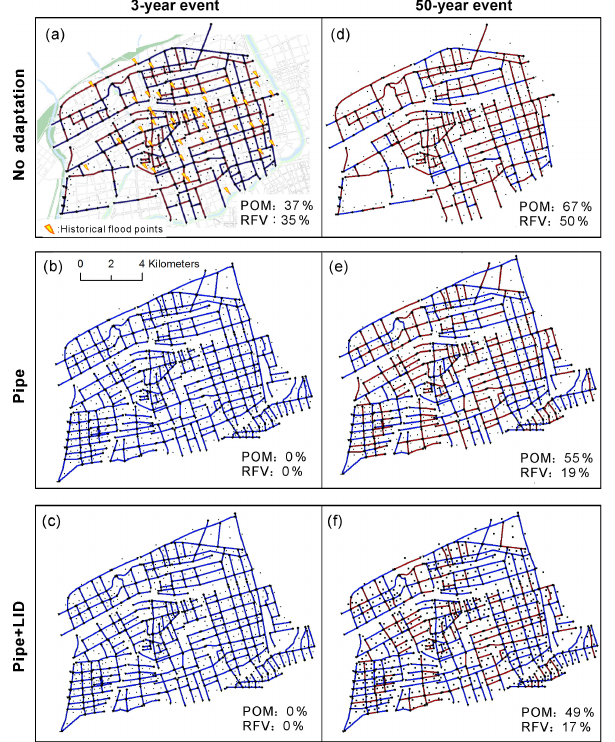
Figure 5. Spatial distribution of overloaded pipelines (red colour) induced by the 3-year (a–c) and 50-year extreme events (d–f) with- out and with adaptations. The total percentage of overloaded man- holes (POM) and ratio of flood volume (RFV) to input rainfall vol- ume are summarised for each scenario. Historical flood points and local land use, mainly the traffic network and green spaces, are shown in (a) .